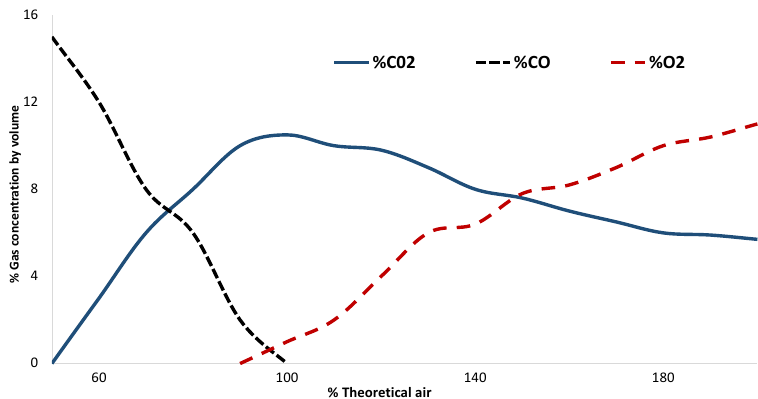
Figure 8. Combustion gas concentrations as a percent of the theoretical combustion of air.